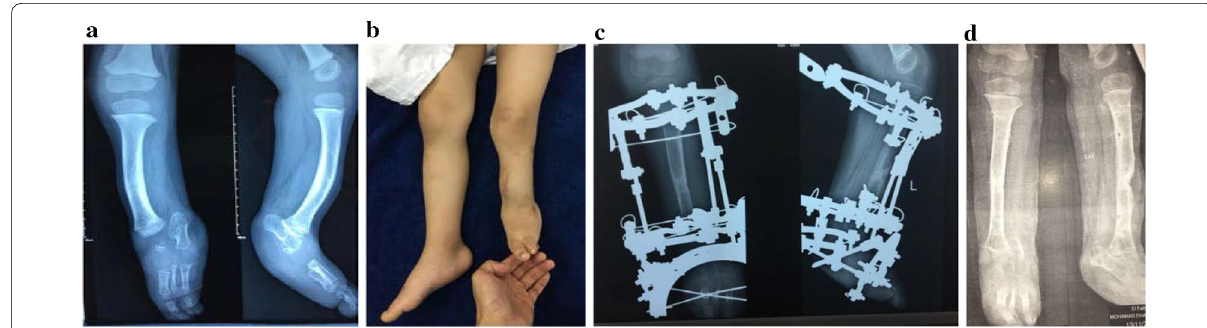
Table 1 Overall complication rate during lengthening